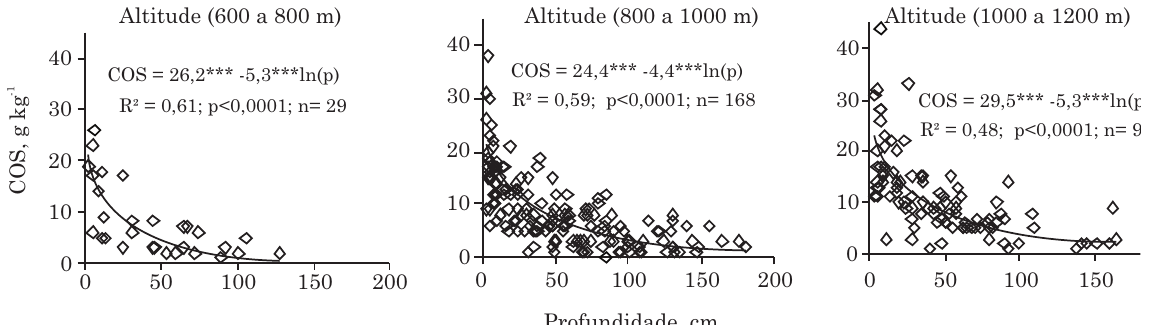
Figura 7. Perfis de carbono orgânico do solo (COS) para três faixas de altitude na região Sul de MG. O nível de significância para os parâmetros intercepto e fator logarítmico é representado por *,** e ***, respectivamente, para p<0,05, p<0,01 e p<0,001.